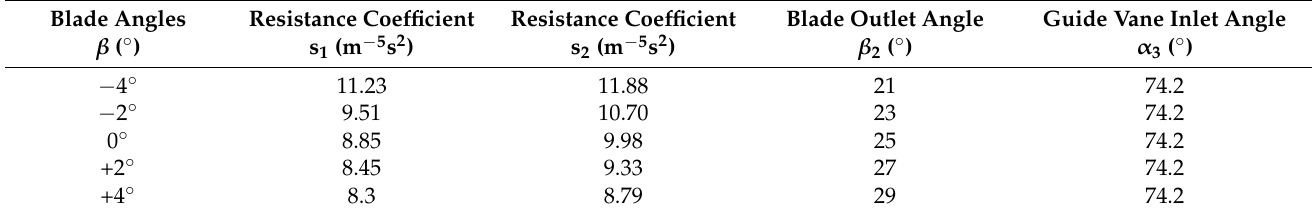
Table 3. Runaway characteristic